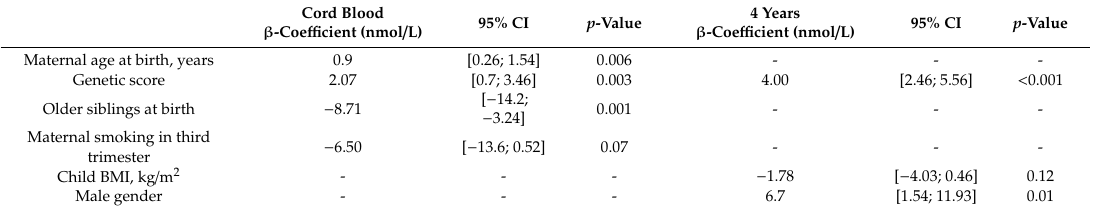
Table 4. Results from final multivariate forward regression analyses of child season-adjusted 25(OH)D